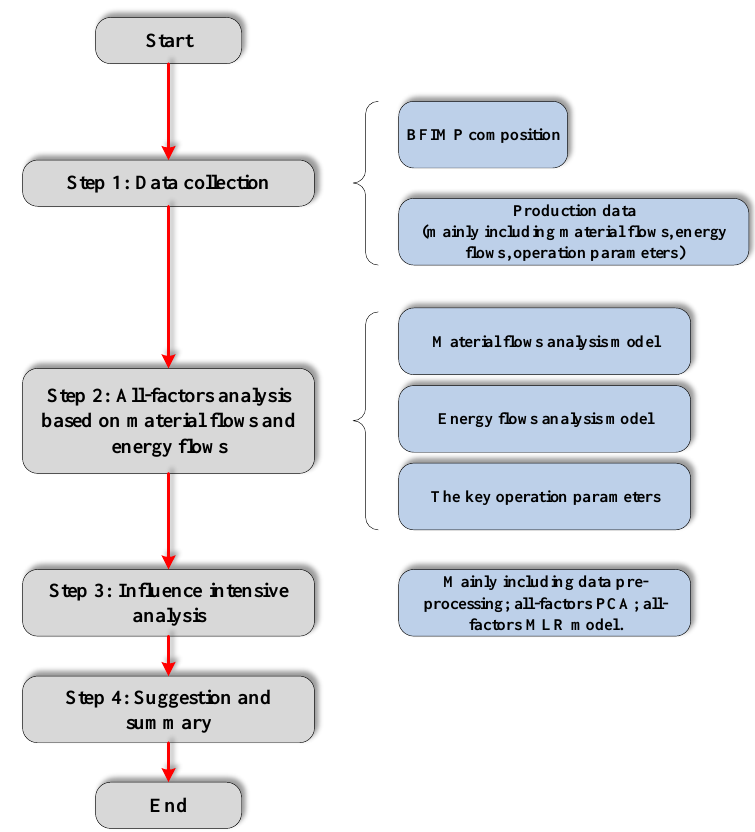
Figure 1. The research route of the all-factors analysis approach.